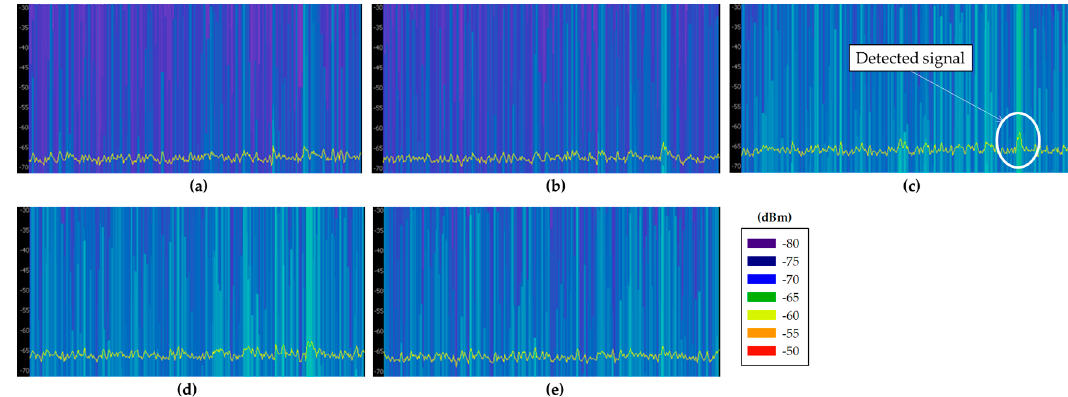
Figure 5. Measured spectrograms at 433 MHz central frequency with 20 MHz bandwidth: ( a ) within Box 2; ( b ) within Box 18; ( c ) aisle in front of Box 6; ( d ) aisle in front of Box 18; and ( e ) in the middle of the scenario.